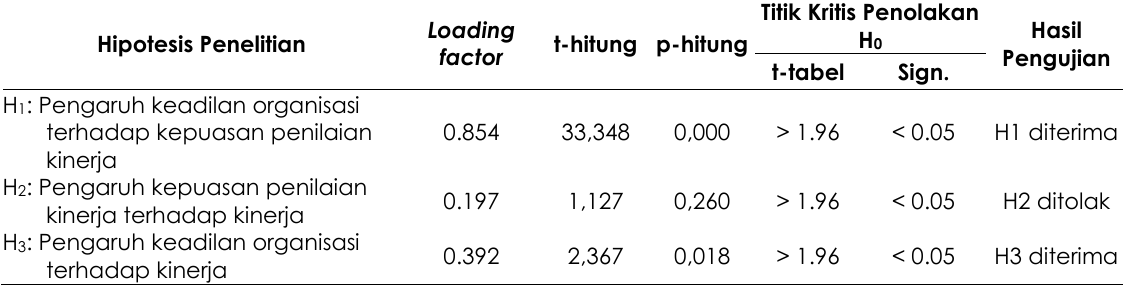
Tabel 9. Hasil pengolahan prosedur bootstraaping dengan SmartPLS Hipotesis Penelitian